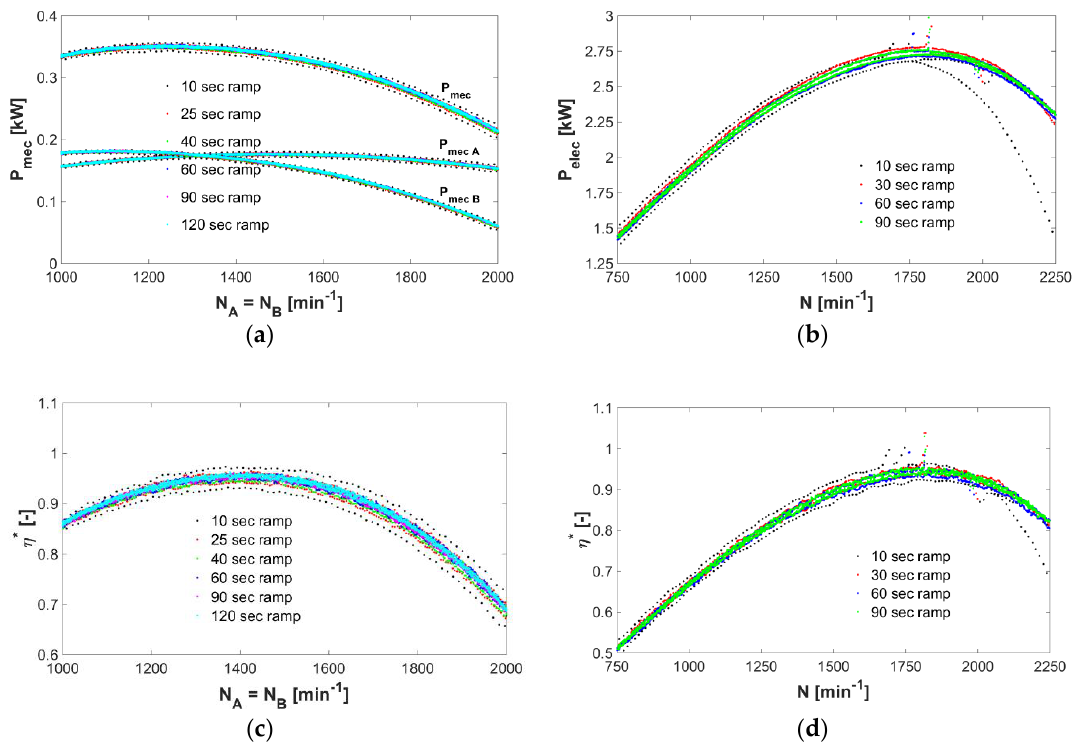
Figure 6. Influence of the acceleration/deceleration ramp of the runner(s) speed on the power and on the efficiency during one forth and back cycle at fixed testing inflow conditions: ( a ) variation of the counter-rotating microturbine mechanical power (N p1,2,3 = 1500 min − 1 ); ( b ) variation of the PAT electrical power (N p1,2,3 = 2000 min − 1 ); ( c ) variation of the counter-rotating microturbine efficiency (N p1,2,3 = 1500 min − 1 ); ( d ) variation of the PAT efficiency (N p1,2,3 = 2000 min − 1